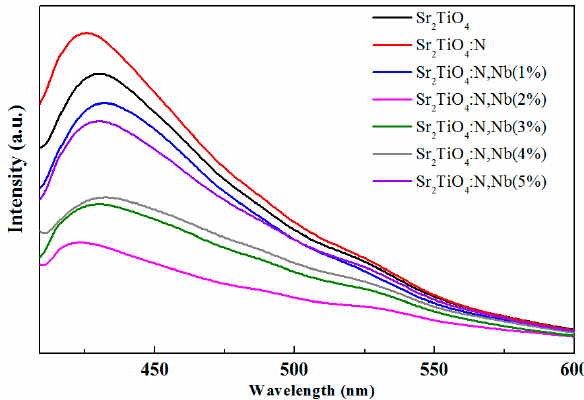
Figure 6. Photoluminescence (PL) spectra of Sr 2 TiO 4 and Sr 2 TiO 4 :N,Nb.